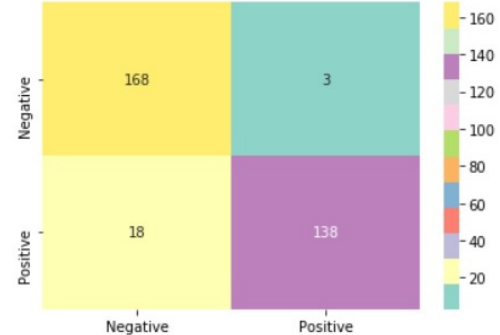
Figure 13. Confusion matrix for the CNN-based model